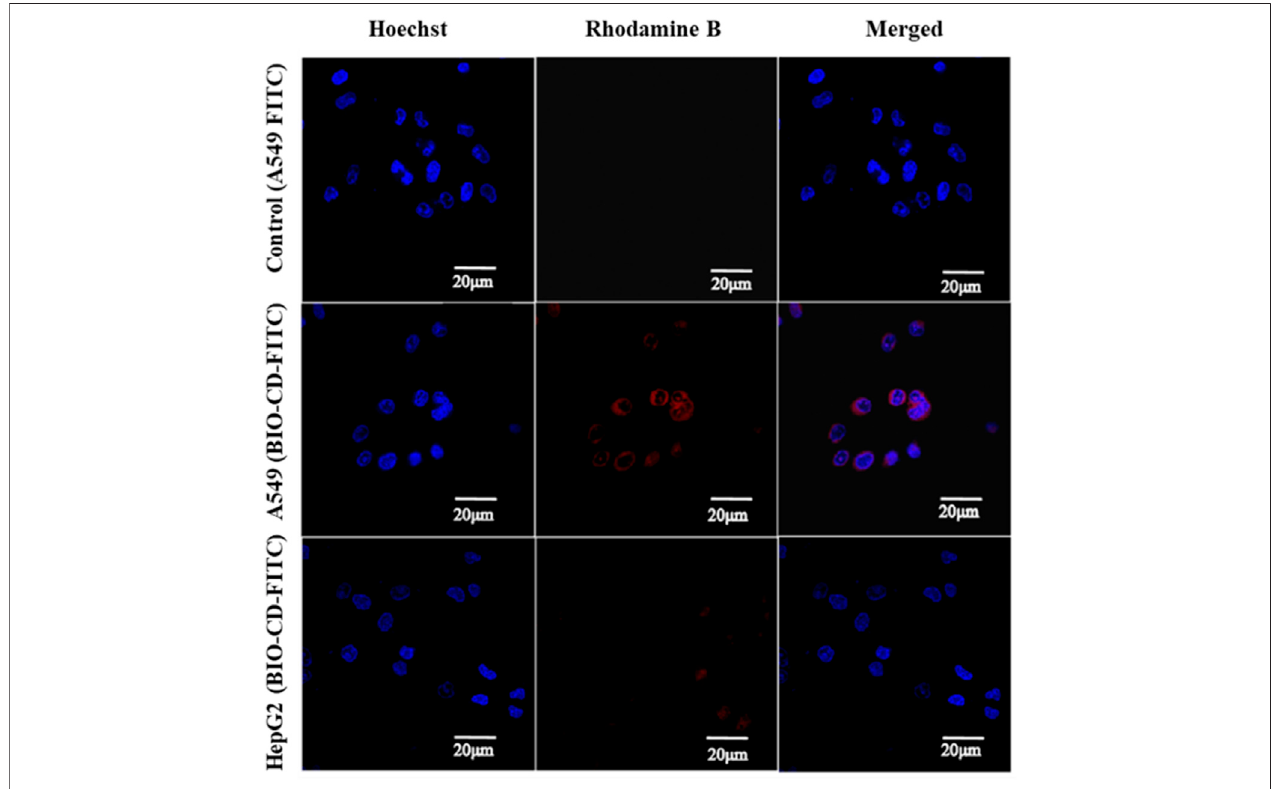
FIGURE12| TargeteddeliveryofamodeldrugRhodamineBusingBIO-CDinHeLacellsandA549cellmodels,showingtheselectivebindingcapabilityofBIO-CD to cells with biotin receptors.